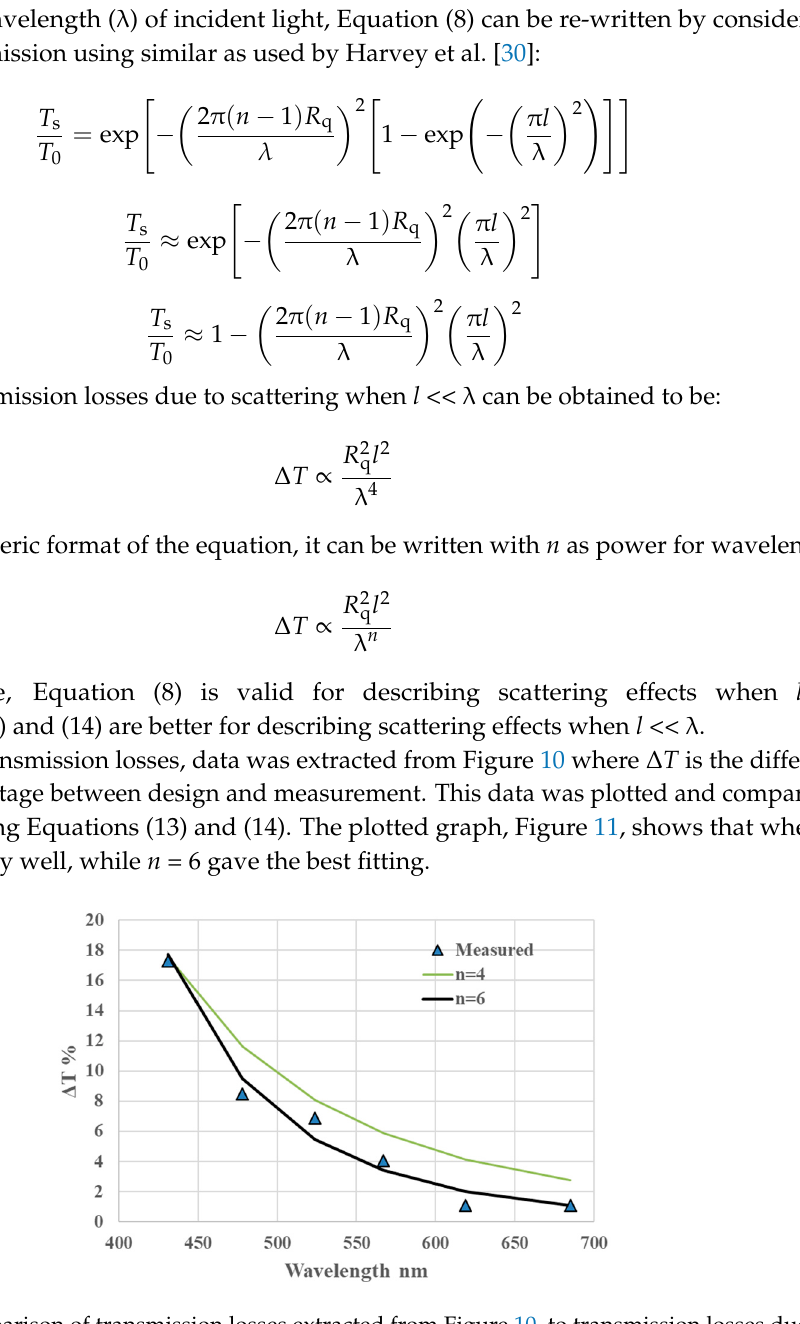
Figure 11. Comparison of transmission losses extracted from Figure 10, to transmission losses due to scattering using Equation (14), with different n values.